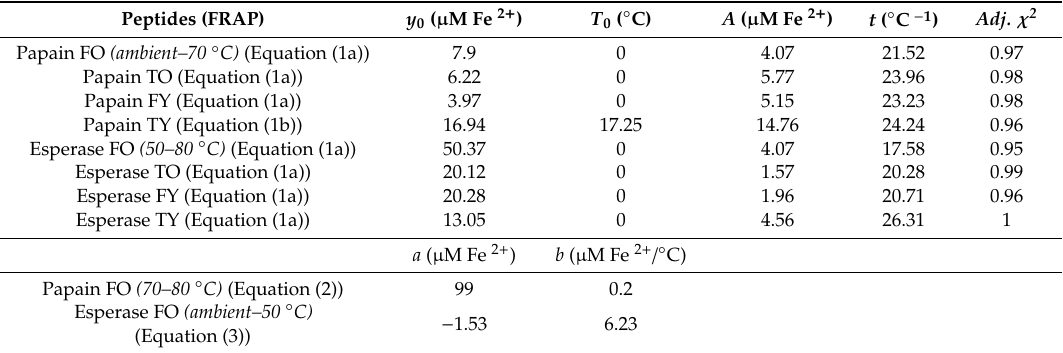
Table 6. Kinetics parameter for the iron reducing activity models (Equation (1a) and (1b)) and models adjustment (Adj. χ 2 ) for papain and esperase peptides. FO = old femur, 10 years; TO = old